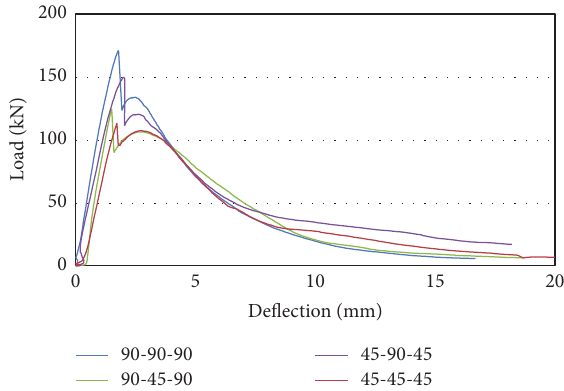
Figure 13: Load-mid span deflection curves of three-layered BFRP HPFRCC